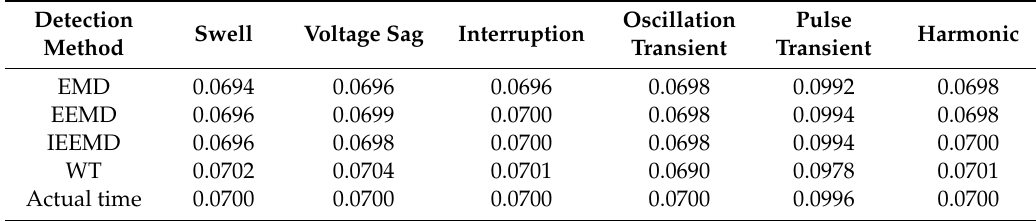
Table 2. The test results of the disturbances start time point.